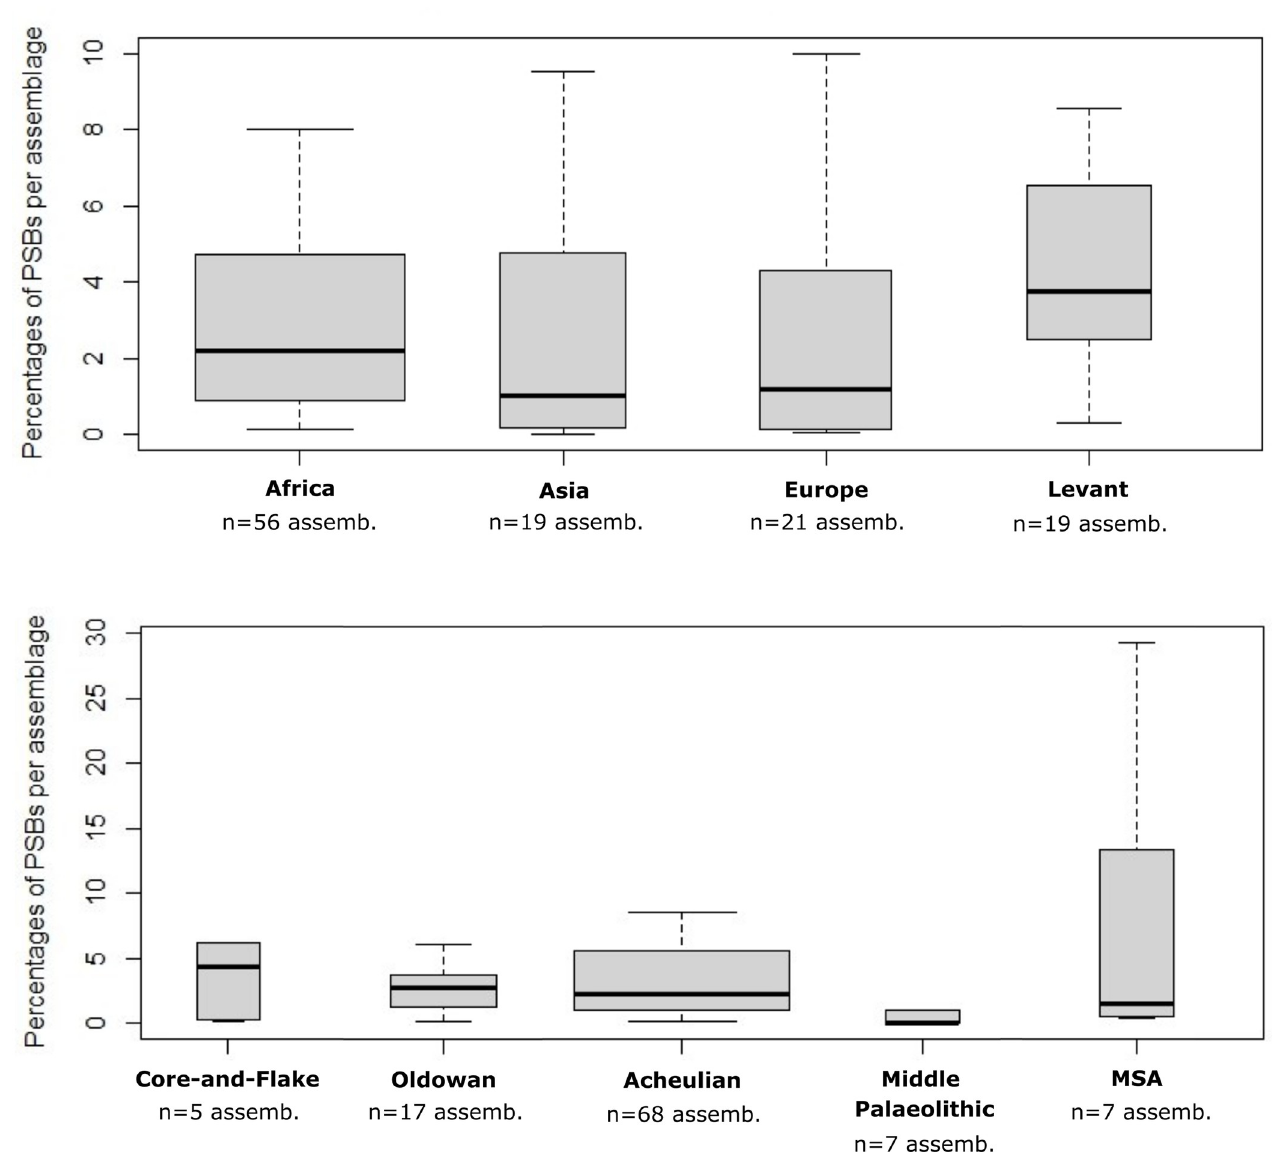
Fig 5. Proportions of PSBs in lithic assemblages according to regions and chrono-cultural attributions. The width of each column is proportional to the number of assemblages considered. Assemb.: assemblages. Outliers not displayed in the construction of the graph.